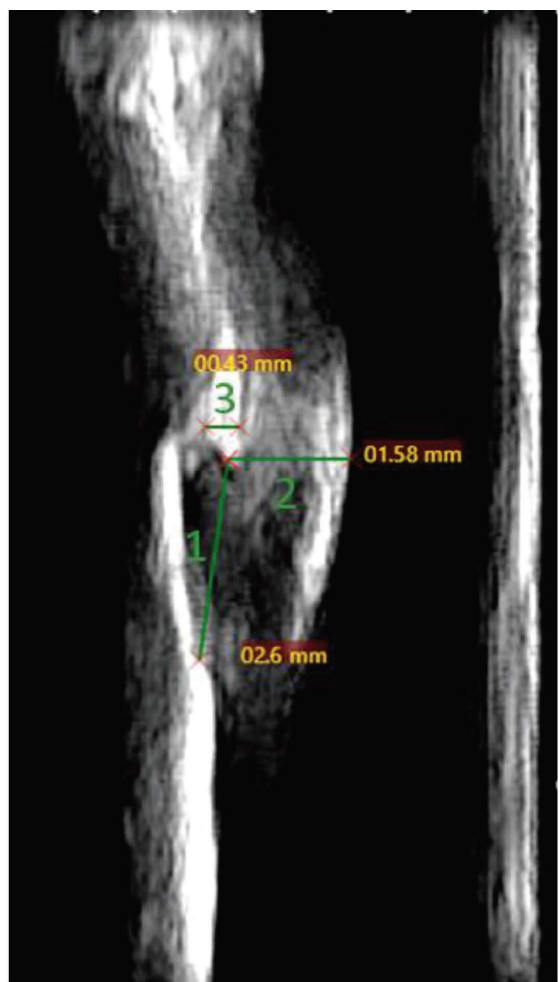
Figure 3: Measurements compared. 1, ABC-CEJ; 2, GT; 3, ABT. Followed by examples of measurements on the same